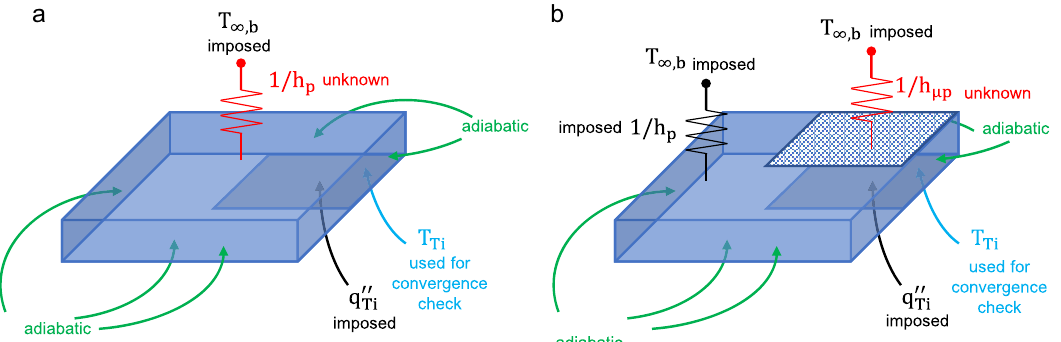
Fig. 8 Geometry (not to scale) and boundary conditions for the 3D conduction inverse problem. a Plain surface. b Engineered surface with